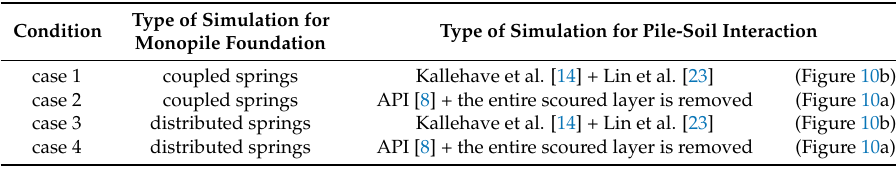
Table 4. Conditions for simulations. API: American Petroleum Institute.